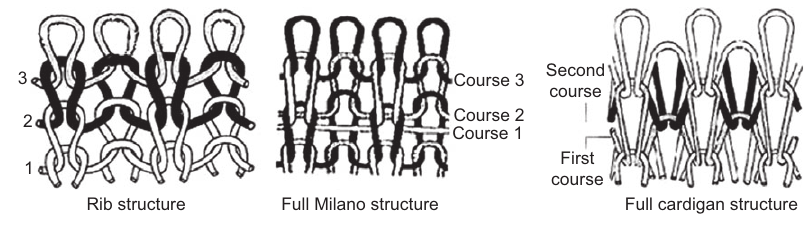
Figure 1 Knitted fabric structures.